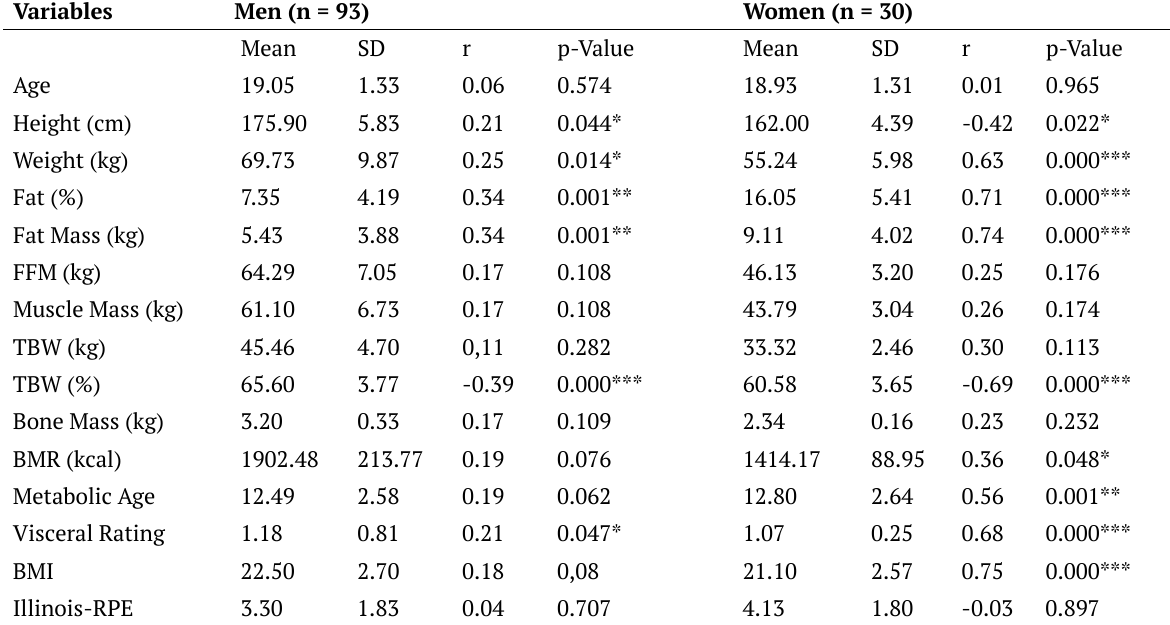
Table 1. Pearson Correlation analysis of male and female Illinois Agility Test scores with age, height, weight, and anthropometric